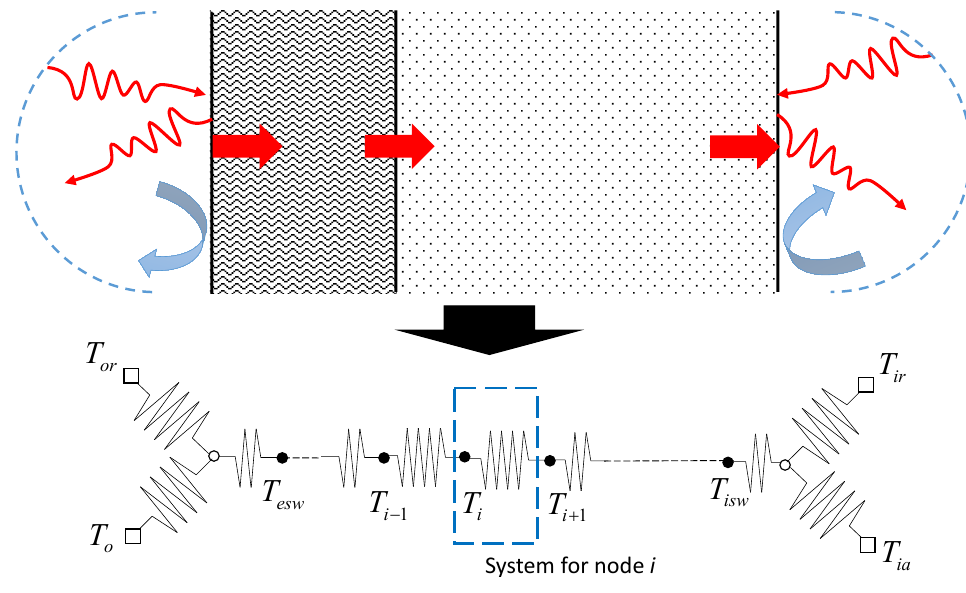
Figure A1. Model and equation of built environmental system